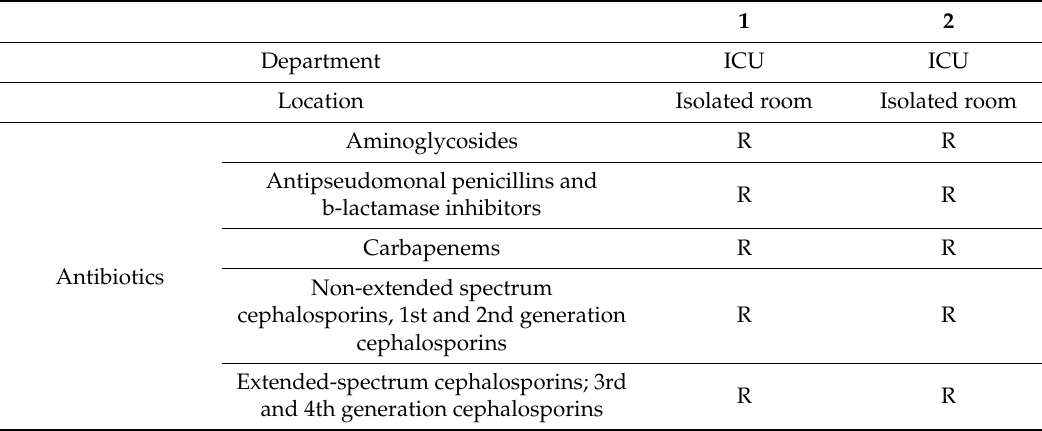
Table 4. Results of the Sensitivity Tests for MDR Kl. pneumoniae.